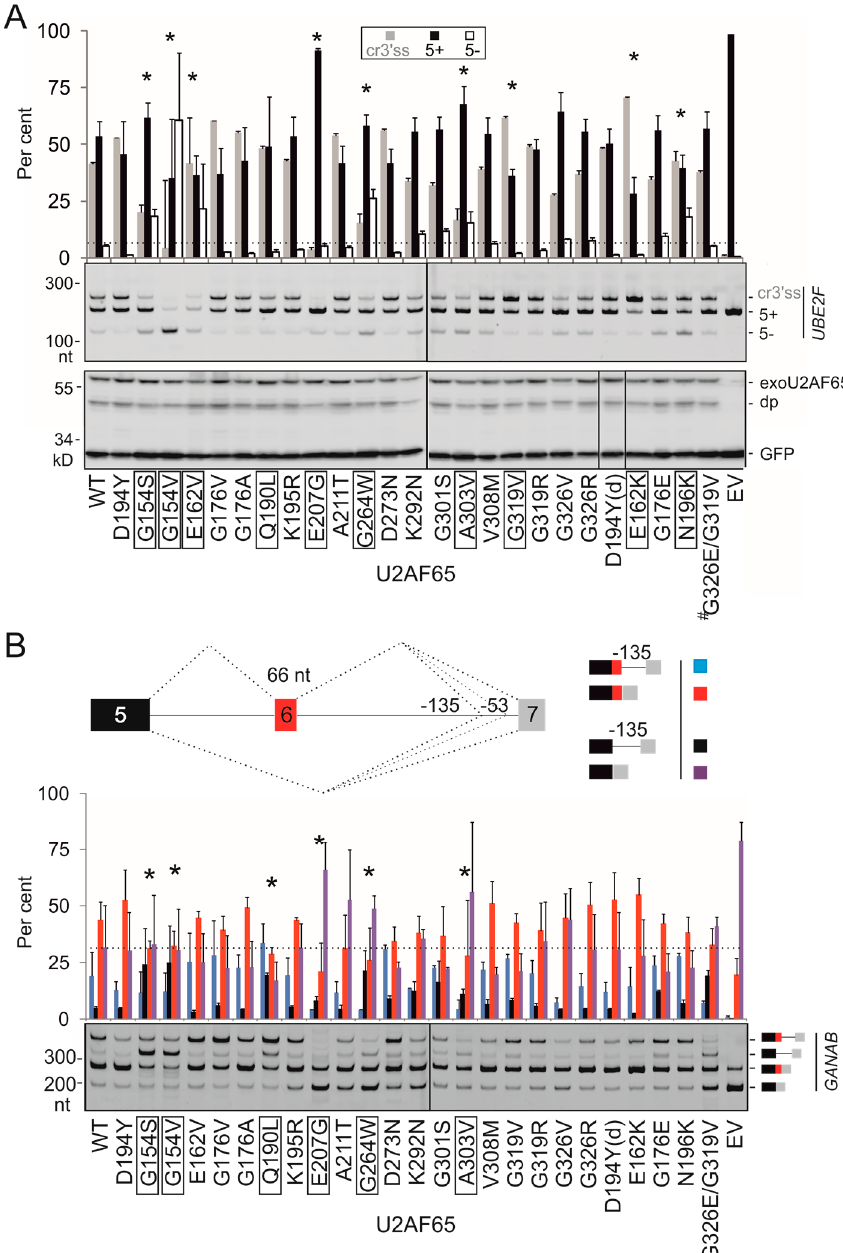
Figure 3. Splicing activities of cancer-associated U2AF65 RRM substitutions. ( A ) UBE2F splicing activities (upper panel) and immunoblotting of lysates from transfected HEK293 cells with anti-c- myc antibodies, which detect exogenously expressed protein (lower panel). The relative usage of UBE2F products is quantified at the top. WT, wild-type; EV, empty vector; # , double mutant. The bar chart represents the average of four independent transfections ± SEM. One-way analysis of variance was performed with Dunnett’s multiple comparison post-hoc t-tests (STAT200). Asterisks denote significant deviations of mutated plasmids from the WT ( p < 0.05). Functional substitutions are boxed. dp, degradation product. Dotted horizontal line indicates the level of exon skipping of the WT construct. ( B ) GANAB splicing activities of U2AF65 RRM substitutions. The reporter is shown in the upper panel; RNA products are to the right. The lower panel shows the relative usage of the spliced products. Error bars are SEMs of two independent transfections. Analysis of variance was performed with Dunnett’s multiple comparison post-hoc t-tests (STAT200, Biosoft). Dotted horizontal line denotes exon 6 skipping in the WT. Cryptic 3 ′ ss at position -53 (Figure S1) was used at <2% and was disregarded.